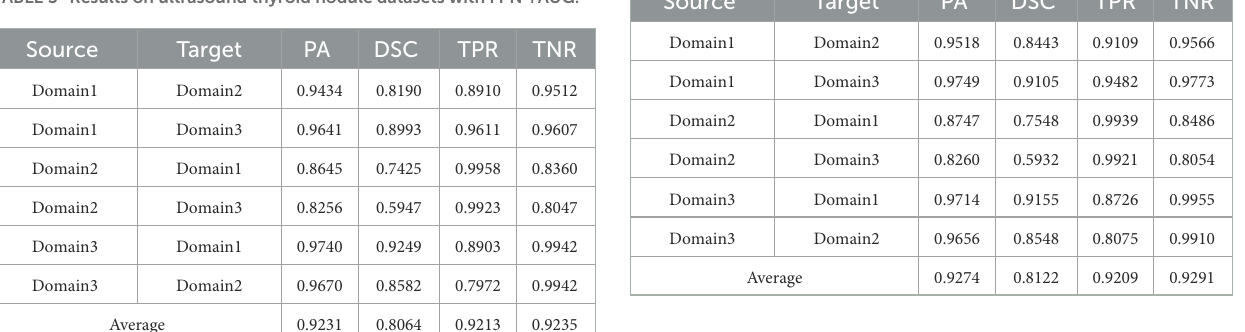
TABLE 3 Results on ultrasound thyroid nodule datasets with FPN +AUG.